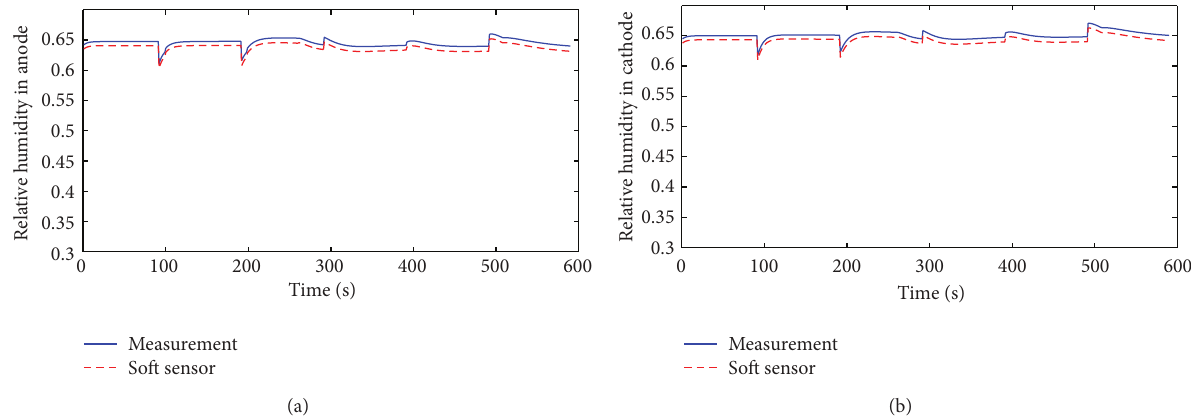
Figure 15: Comparison of measured and soft sensor’s relative humidity with rapid start when relative humidity of cathode is set as 0.65. (a) Anode; (b)